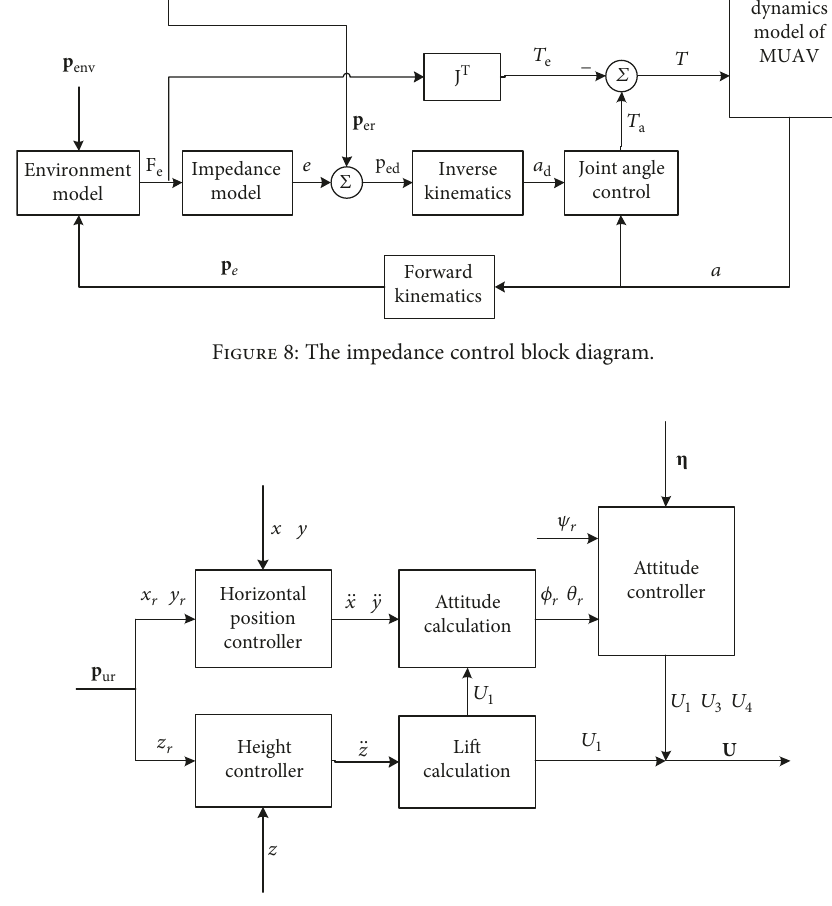
Figure 9: The quadrotor control block